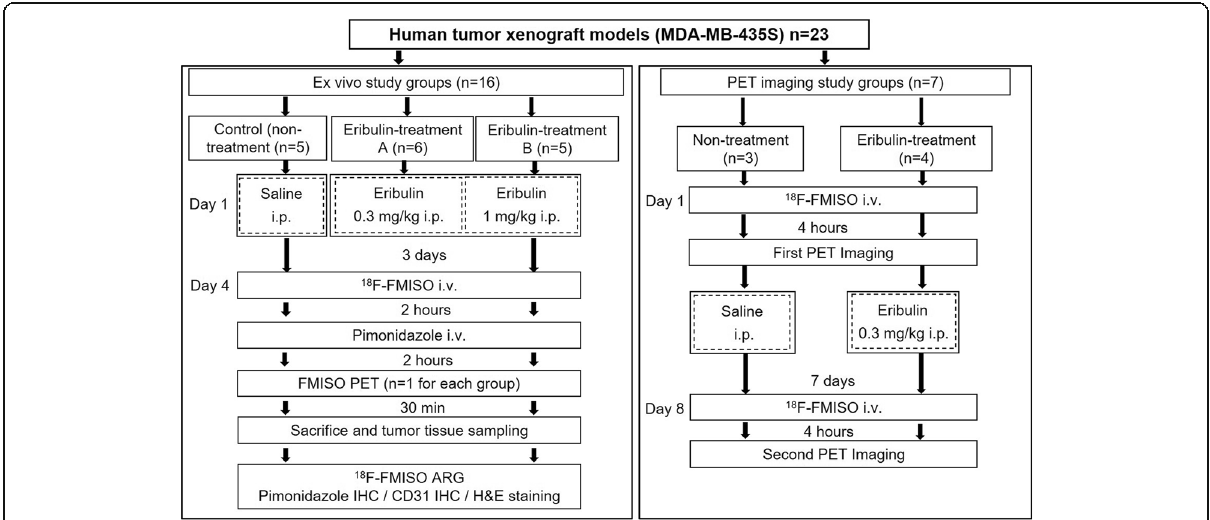
Fig. 1 Experimental protocol of this study. The left panel shows the ex vivo study with control (non-treatment) and two eribulin treatment (A, 0.3 and B, 1.0 mg/kg) groups. The right panel shows PET imaging study with control (non-treatment) and eribulin treatment (0.3 mg/kg)